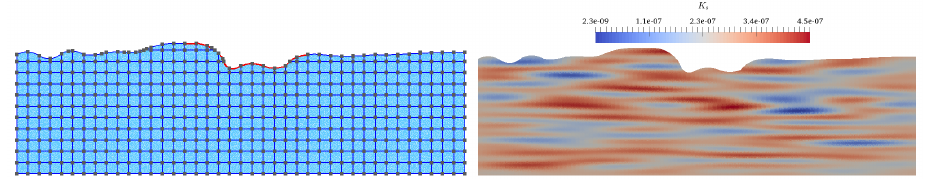
Figure 3. Computational domain and heterogeneous coefficient K s ( x ) (two-dimensional problem).